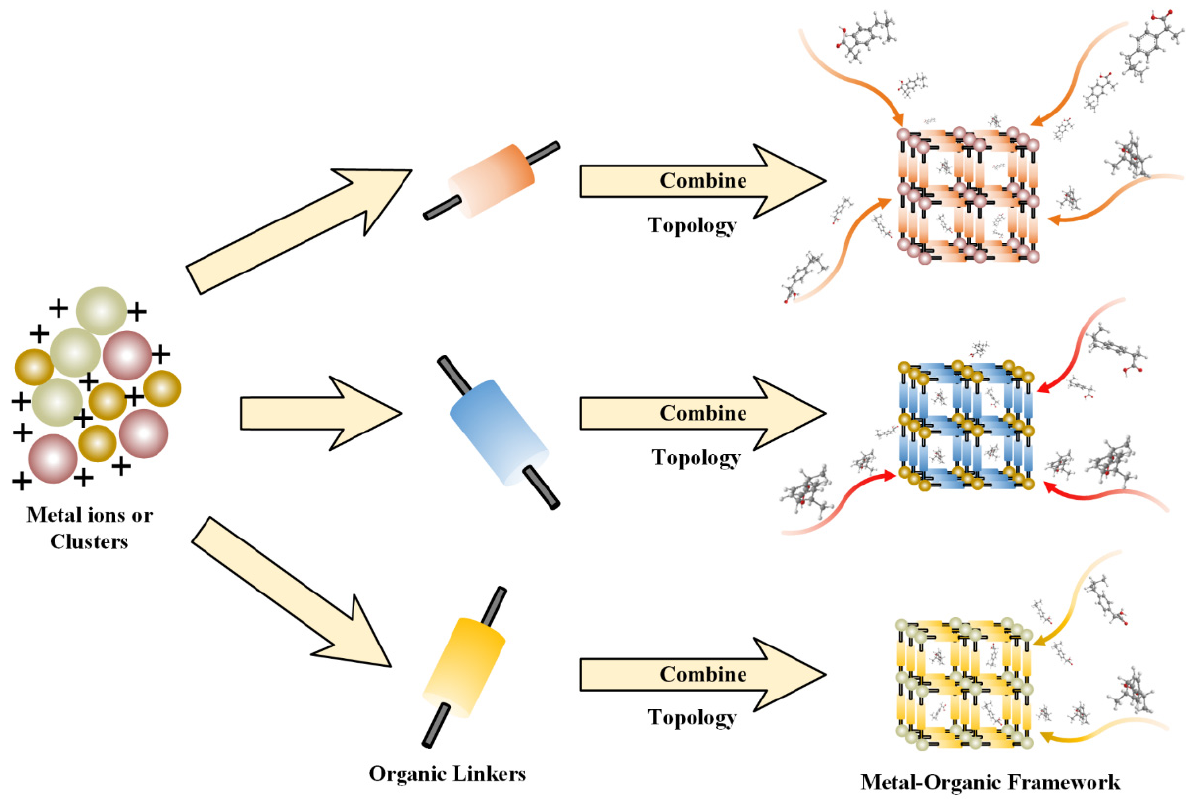
Figure 1. The schematic diagram of metal-organic frameworks (MOFs). The combination of various available clusters or inorganic metal ions (Fe, Cr, Zn, and so on) and organic linkers (1,4-Benzenedicarboxylate, Benzene-1,3,5-tricarboxylate, gamma-Cyclodextrin ( γ -CD), and so on), which are suitable with a framework topology, can contribute to differently designed porous MOFs.